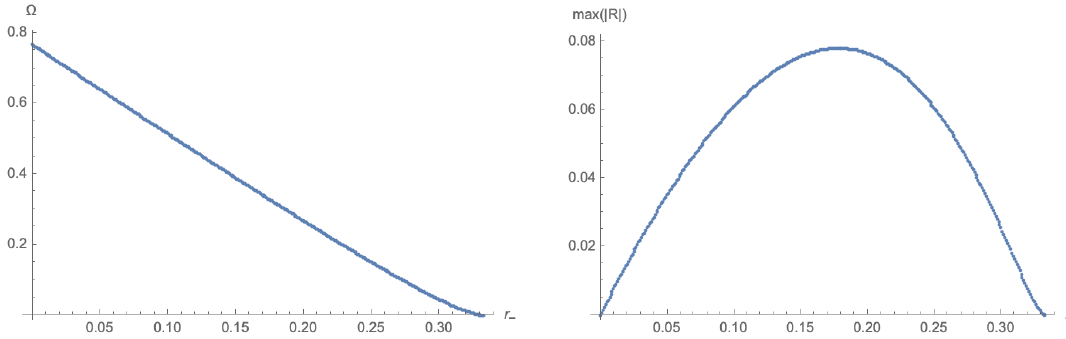
Figure 1 . The left panel shows the eigenvalue, Ω , of the one unstable mode for the flow of the non-extremal magnetically charged RN solution against r − which controls its charge. For r − = 0 this is the Gross-Perry-Yaffe negative mode of Schwarzschild. For charges 0 < r − < 1 / 3 this unstable mode persists, disappearing at r − = 1 / 3 , when it becomes a zero mode which is generated by a perturbation within the RN family of solutions. For greater charges the fixed point is stable (within this spherically symmetric setting). ξ remains zero for all these unstable modes, and in the right panel the maximum value of the perturbation to the Ricci scalar for the mode is shown.